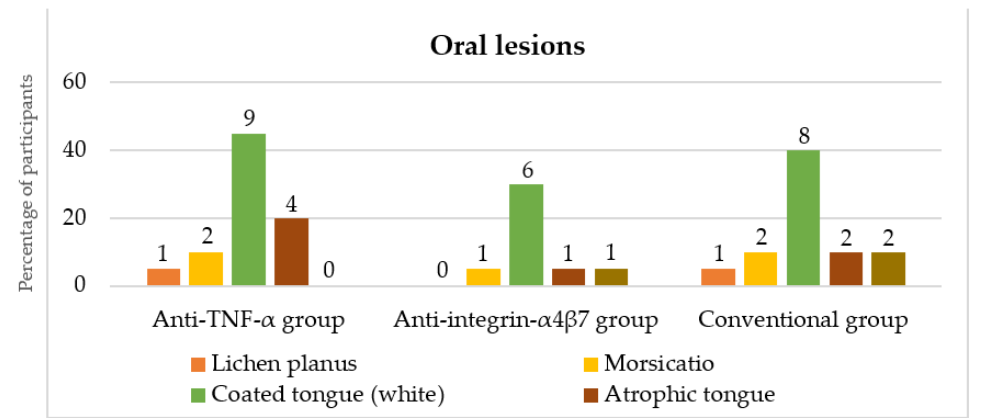
Figure 3. Distribution of oral mucosal lesions presented during the clinical examination in the anti- TNF- α , anti-integrin- α 4 β 7 and conventional groups (numbers above columns represent numbers of participants). TNF: tumor necrosis factor.